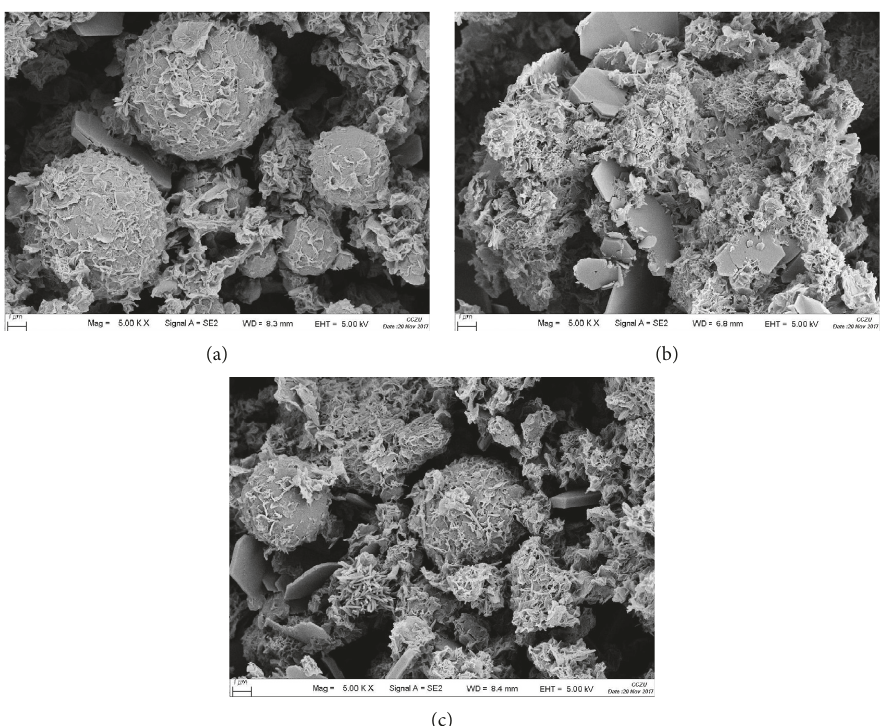
Figure 5: SEM image of bentonite slurry modified by 0.19% PVA (no. A3 in Table 9): (a) curing period � 7 days; (b) curing period � 14 days; (c) curing period � 28